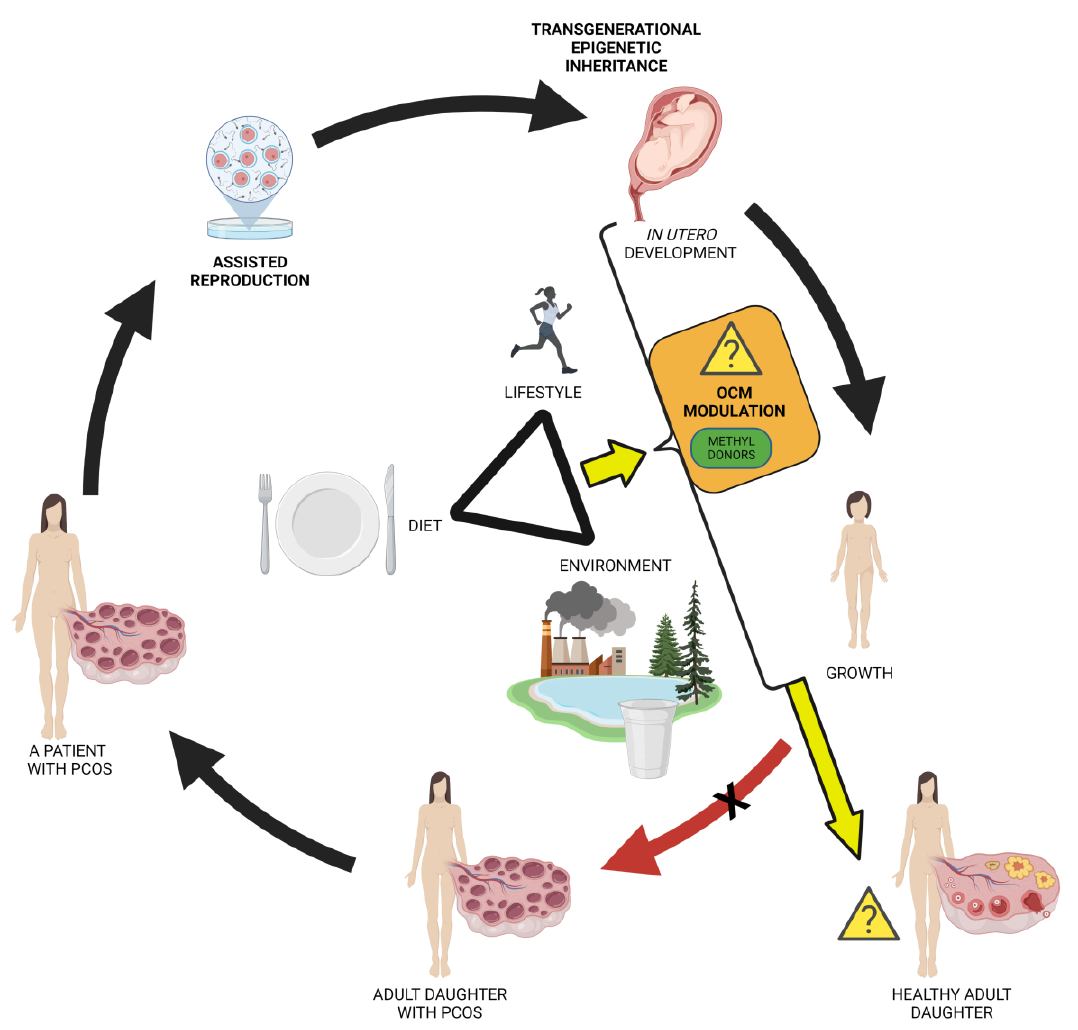
Figure 4. Transgenerational epigenetic inheritance and the therapy (the polycystic ovary syn- drome (PCOS) case: Recent evidence showed that acquired epigenetic changes can be inherited between generations. One such example is the PCOS, which presents the main cause of infertility in humans. PCOS patients are usually managed by assisted reproduction techniques (ART), but there is high probability of transmission from mother to daughter. DNA hypomethylation in PCOS is also influenced by external factors such as nutrition, living environment, or lifestyle [205]. The nutritional supplementation with one carbon metabolism (OCM) compound, the methyl donor S-adenosylmethionine (SAM) could possibly have a therapeutic potential to mitigate or alleviate PCOS in humans [206]. The image was created with BioRender.com.